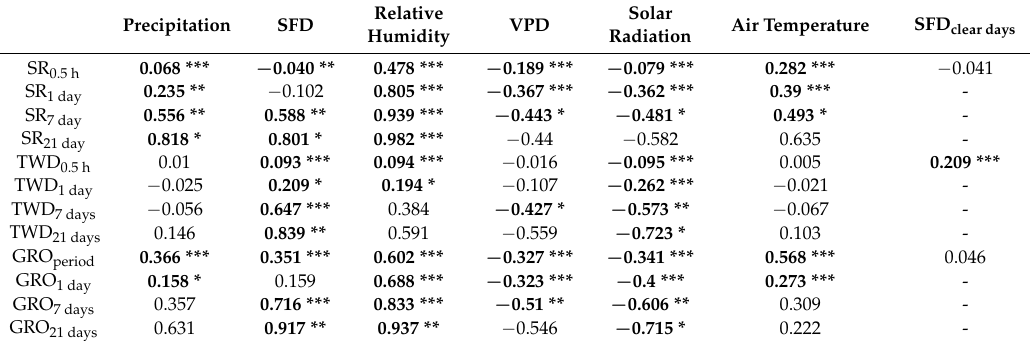
Relative Solar Air Temperature SFD cleardays VPD Radiation Humidity